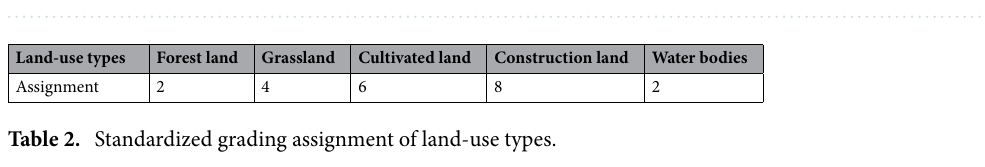
Figure 2. Ecological vulnerability evaluation index system of Shennongjia.